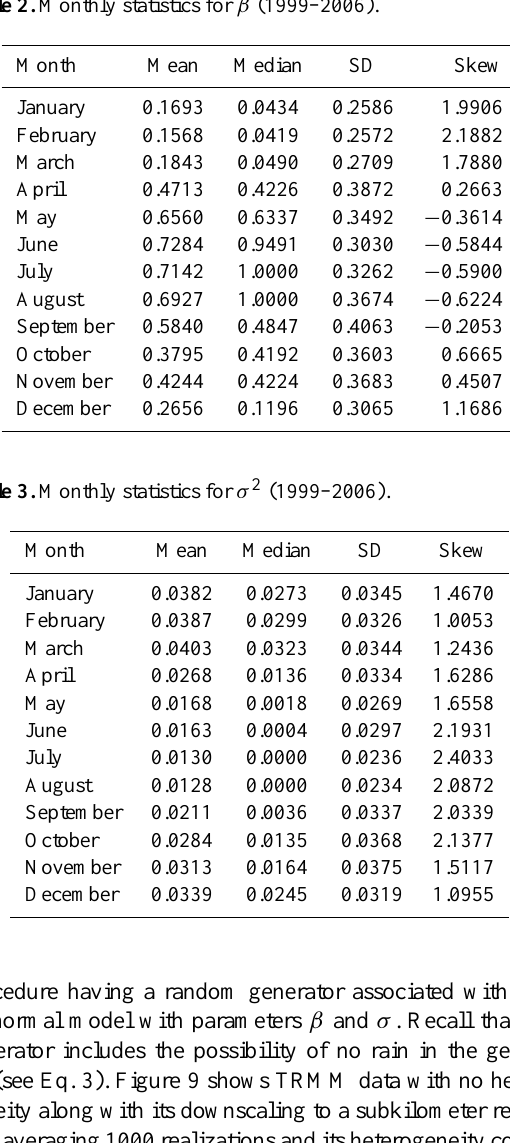
Table 2. Monthly statistics for β (1999–2006).